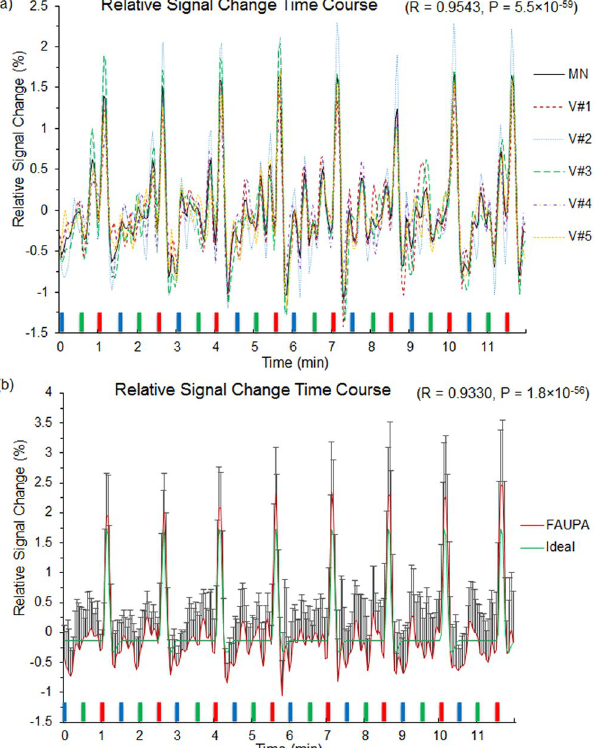
Figure 3. Signal time courses of FT-associated FAUPAs in the left primary motor cortex. ( a ) five signal time courses of the 5 voxels contained in the FT-associated FAUPA for subject 5 (Fig. 1), and the black solid line represents their mean (MN) signal time course. The blue, green and red bars represent the onset and duration of the three tasks of reading words, viewing patterns and tapping right-hand five fingers, respectively. A task- induced large signal change that is associated with the FT task is present for each of the eight tasks. V: voxel; ( b ) comparison of the ideal response signal time course with the group-mean signal time course of the nine FT- associated FAUPAs from the nine subjects. The error bar indicates the standard